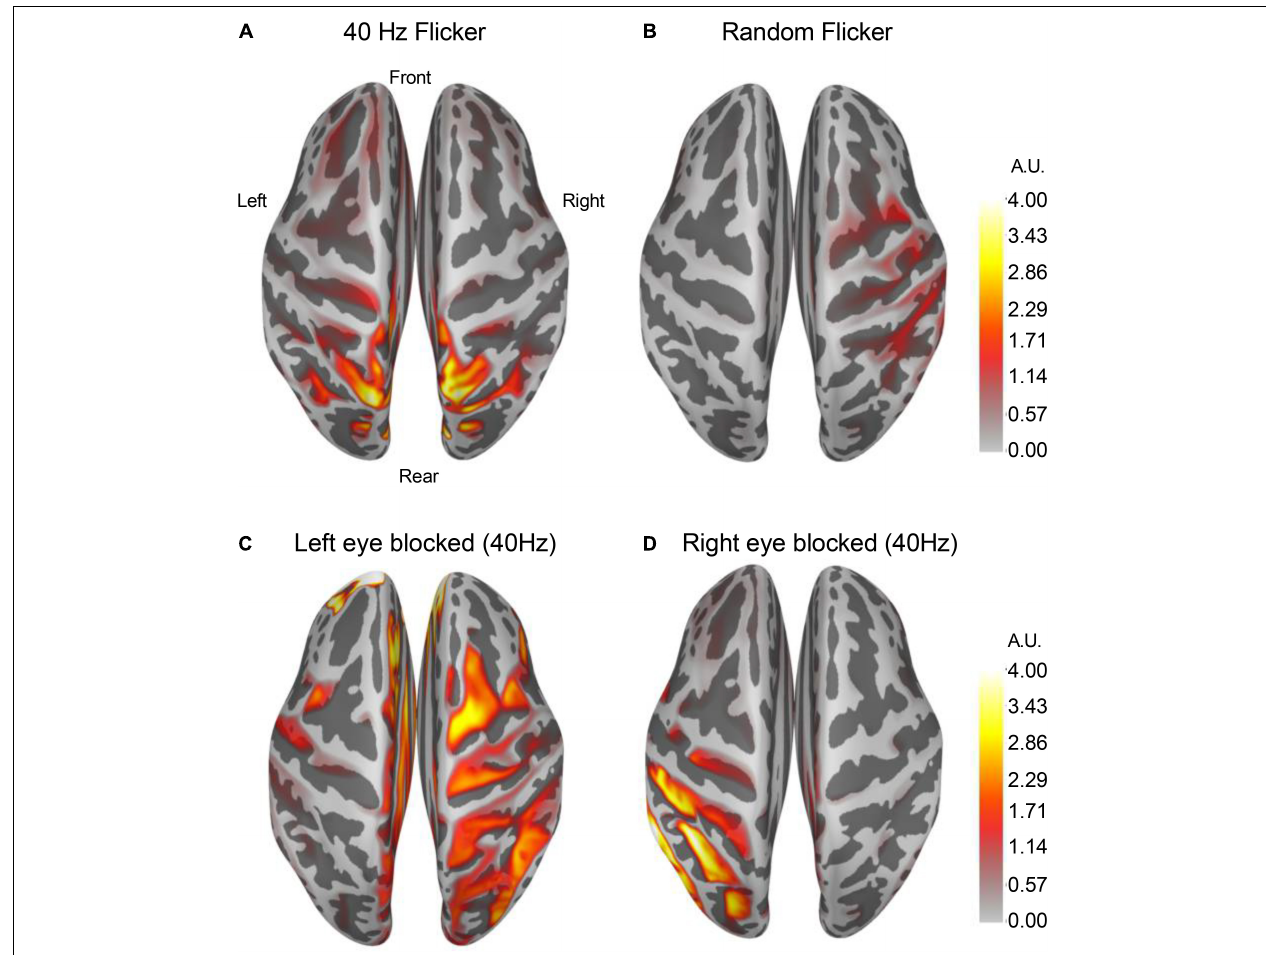
FIGURE 6 | Altered cortical responses in response to 40 Hz light flicker stimulation. The brain cortical neuronal response was determined using dSPM. Average dSPMs pseudo-colored maps of brain cortical representations of increased responses to light flickers were shown in panels (A) (40 Hz light flicker) and (B) (random like flicker). The left [panel (C) ] or the right [panel (D) ] side of the eye was covered during the light flicker test, and the neuronal response in the brain showed a robust ipsilateral increase in response to 40 Hz light flicker stimulation ( n = 4). The colors in the scale bar represent the mapped current density on the corresponding location in arbitrary units